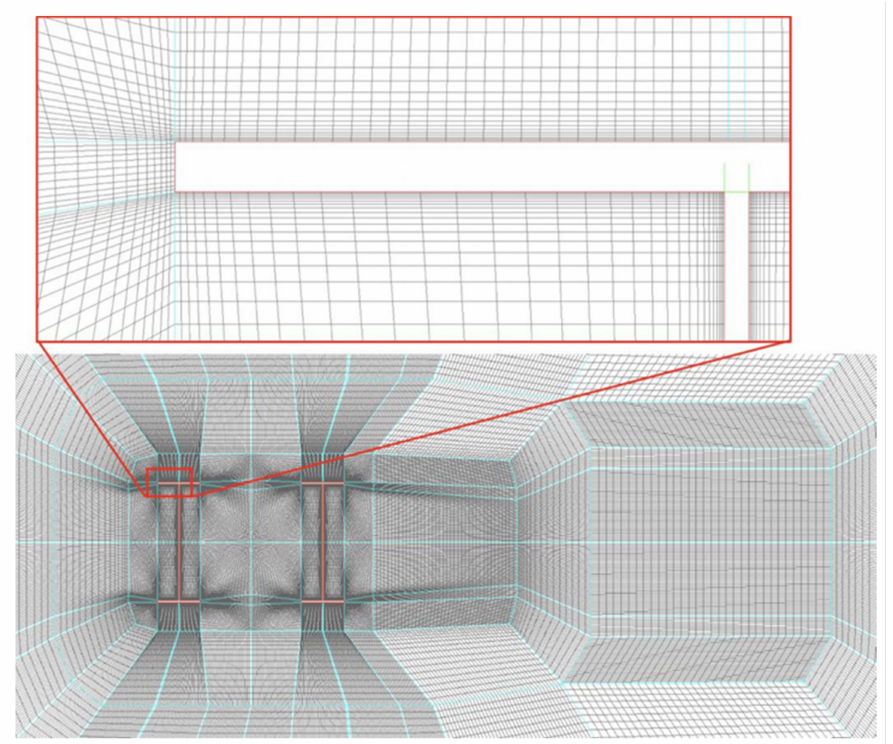
Figure 4. Mesh structure in the surroundings of the structure for a case with two beams (double column, B&W in the printed